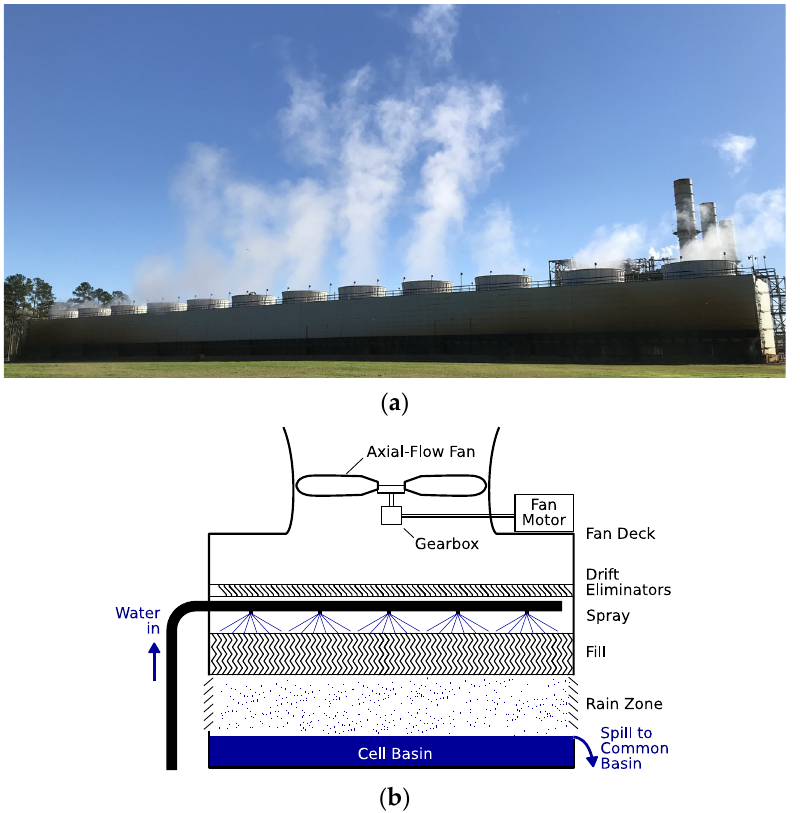
Figure 1. Photo of ( a ) a twelve-cell MDCT and ( b ) an illustration of the components of a single